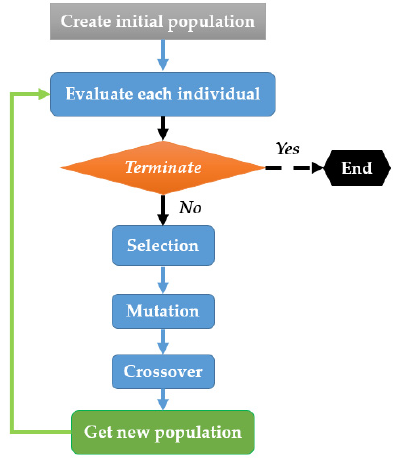
Figure 20. Flowchart for genetic algorithm.